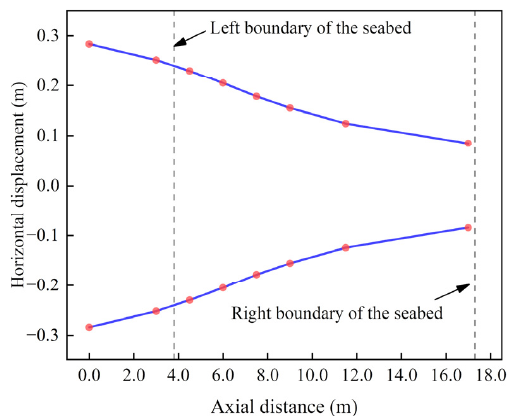
Figure 34. Lateral displacement range of the model SCR.